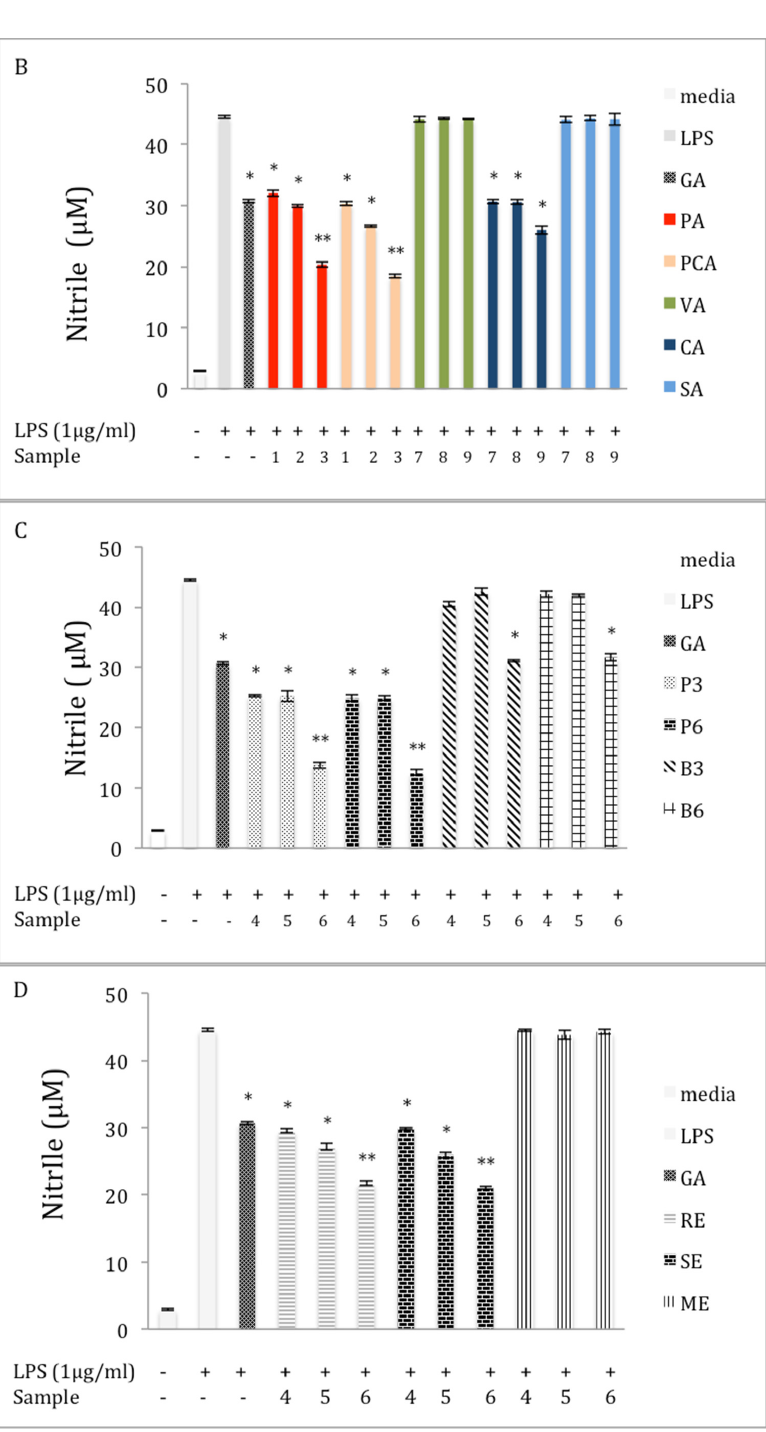
Figure 2. Effect of extracts and phenolics on production of nitric oxide (NO) in macrophage RAW 264.7 cells ( A ) ASE extracts; ( B ) pure phenolic standards; ( C ) crude polysaccharide extracts; and ( D ) different extraction methods. Cells were cultured in the absence ( − ) or presence (+) of LPS (1 µ g/mL) with various concentrations of different samples (- denotes no sample) for 24 h (0 = media; GA = 2 µ M; 1 = 5 µ M; 2 = 10 µ M; 3 = 20 µ M; 4 = 50 µ g/mL; 5 = 100 µ g/mL; and 6= 150 µ g/mL; 7 = 25 µ M; 8 = 50 µ M; and 9 = 100 µ M). NO production was measured by the Griess reagent and is represented as mean ± standard error (SE) in the bars. Statistical significance p < 0.05 (*) and p < 0.01 (**) was determined using one-way analysis of variance for independent means, followed by Tukey’s HSD